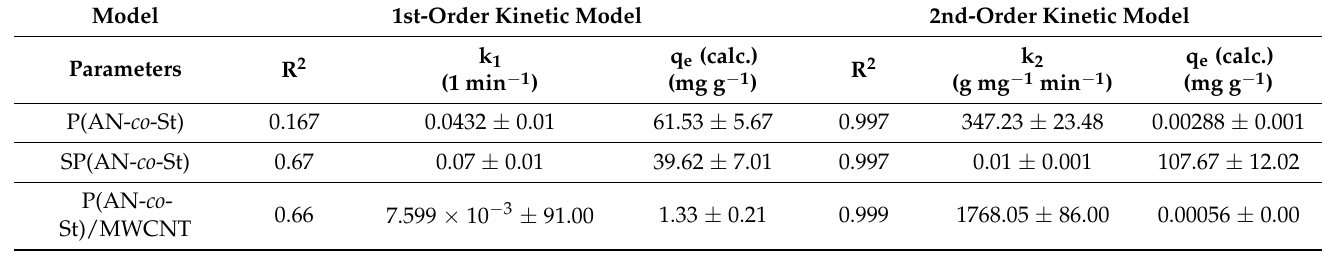
Figure 14. First-order kinetics for the removal of MO onto various composites.